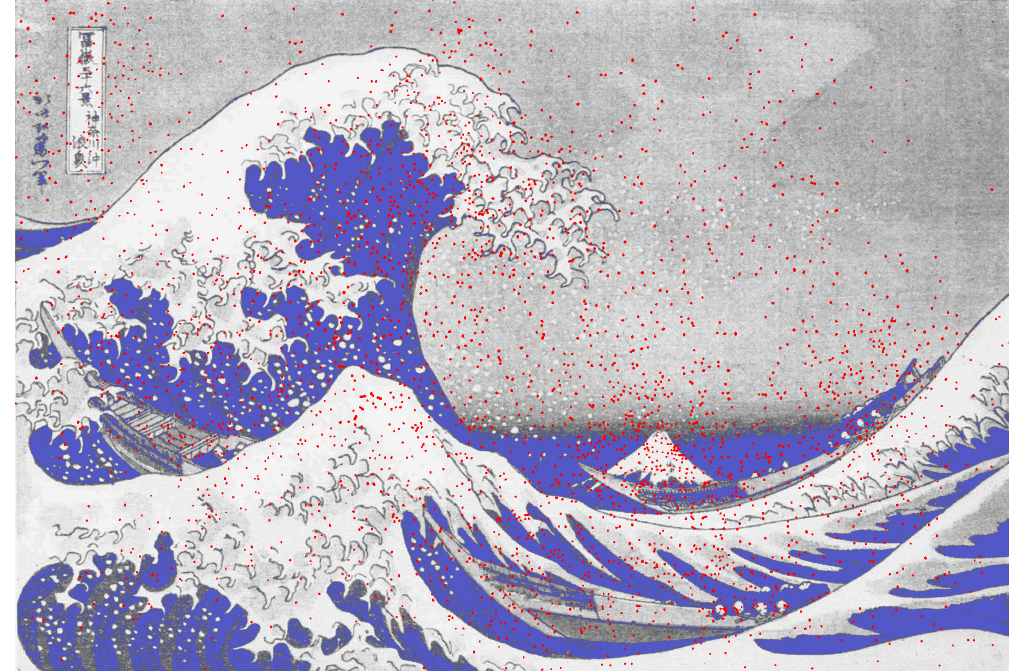
Figure 3. Waves of eye movements 1 . Density plots for all fixations of 42 observers when viewing The Wave by Hokusai. Fixa- tions are denoted by red dots. (Adapted from Picture 13 and Plate XI from Buswell,